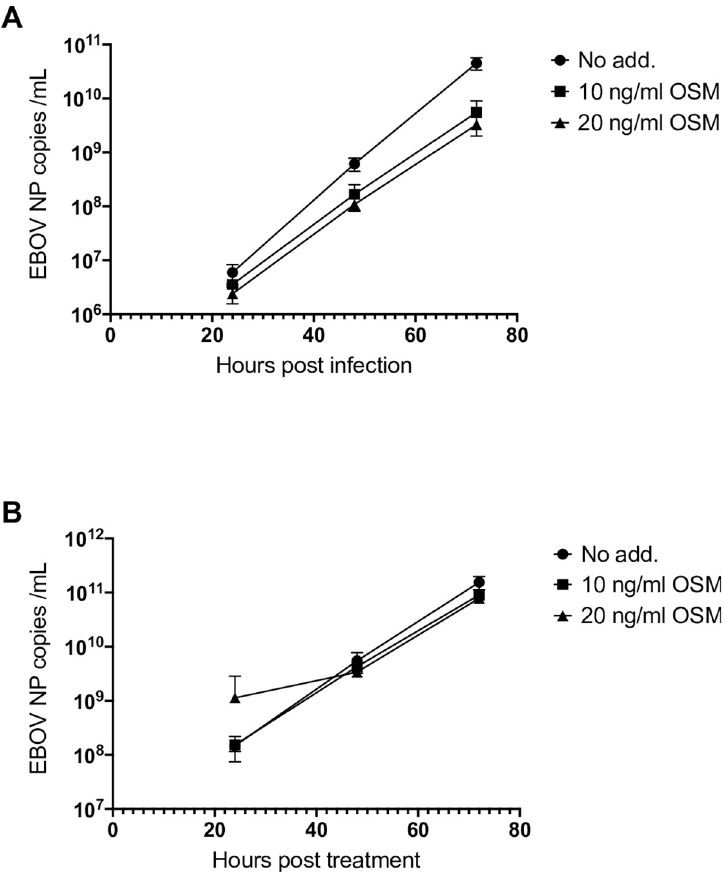
Fig 2. EBOV replication is inhibited by treatment of cells with OSM before infection. E6 Vero cells were treated without or with the indicated concentration of OSM for 24 h before infection with EBOV (MOI 1) for 24 h, 48 h and 72 h (A), or were infected (MOI 1) 24 h before treatment without or with OSM for 24 h, 48 h and 72 h (B). Virus was quantified by RT-qPCR for EBOV NP. Data show mean ± SD; n = 3 biological